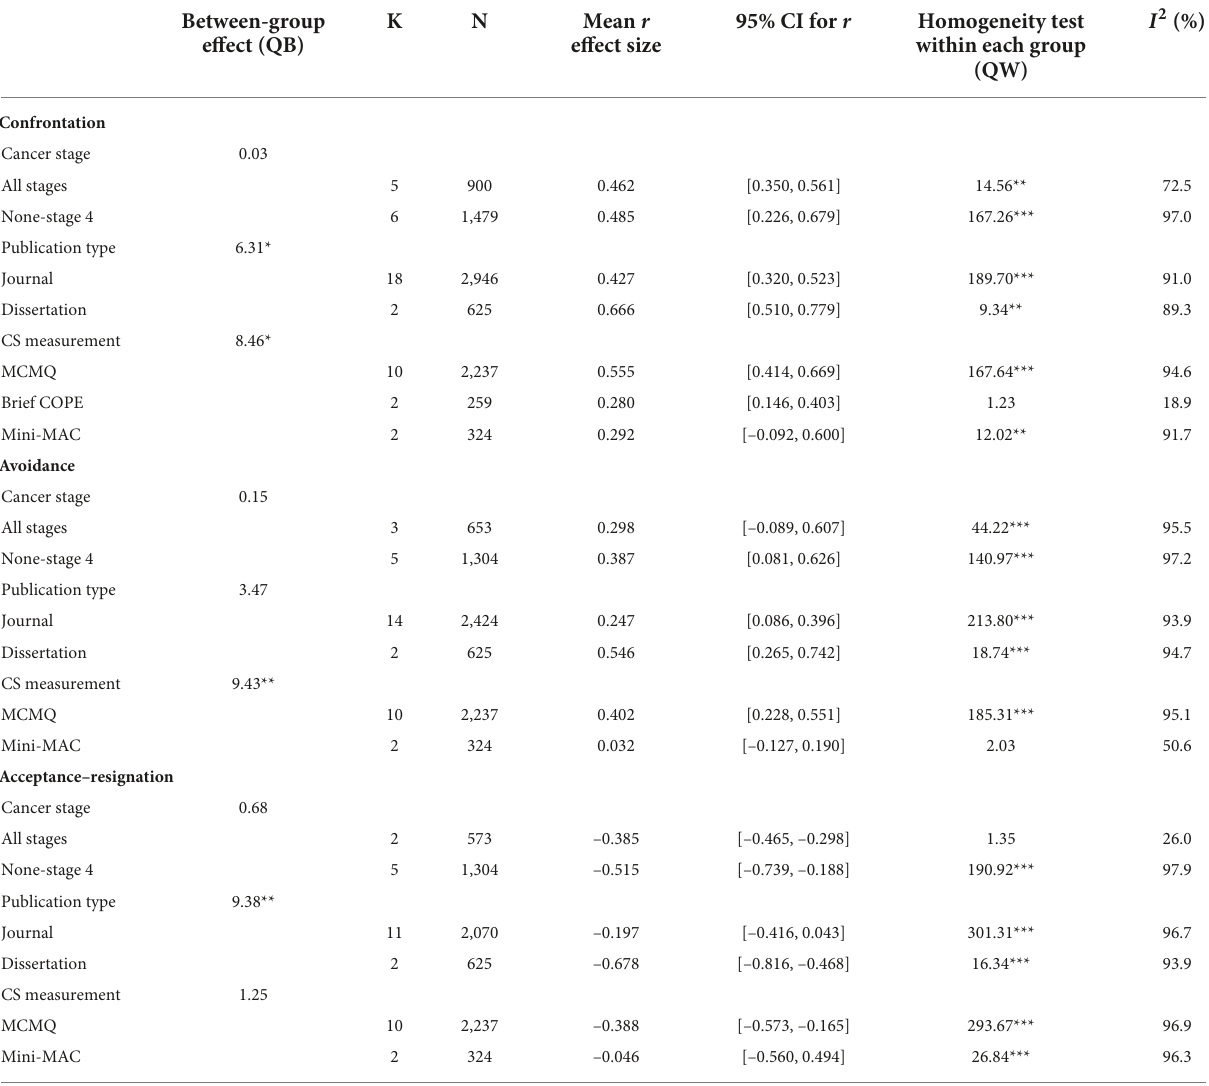
TABLE 3 Coping styles and posttraumatic growth (PTG): Univariate analysis of variance for moderators.